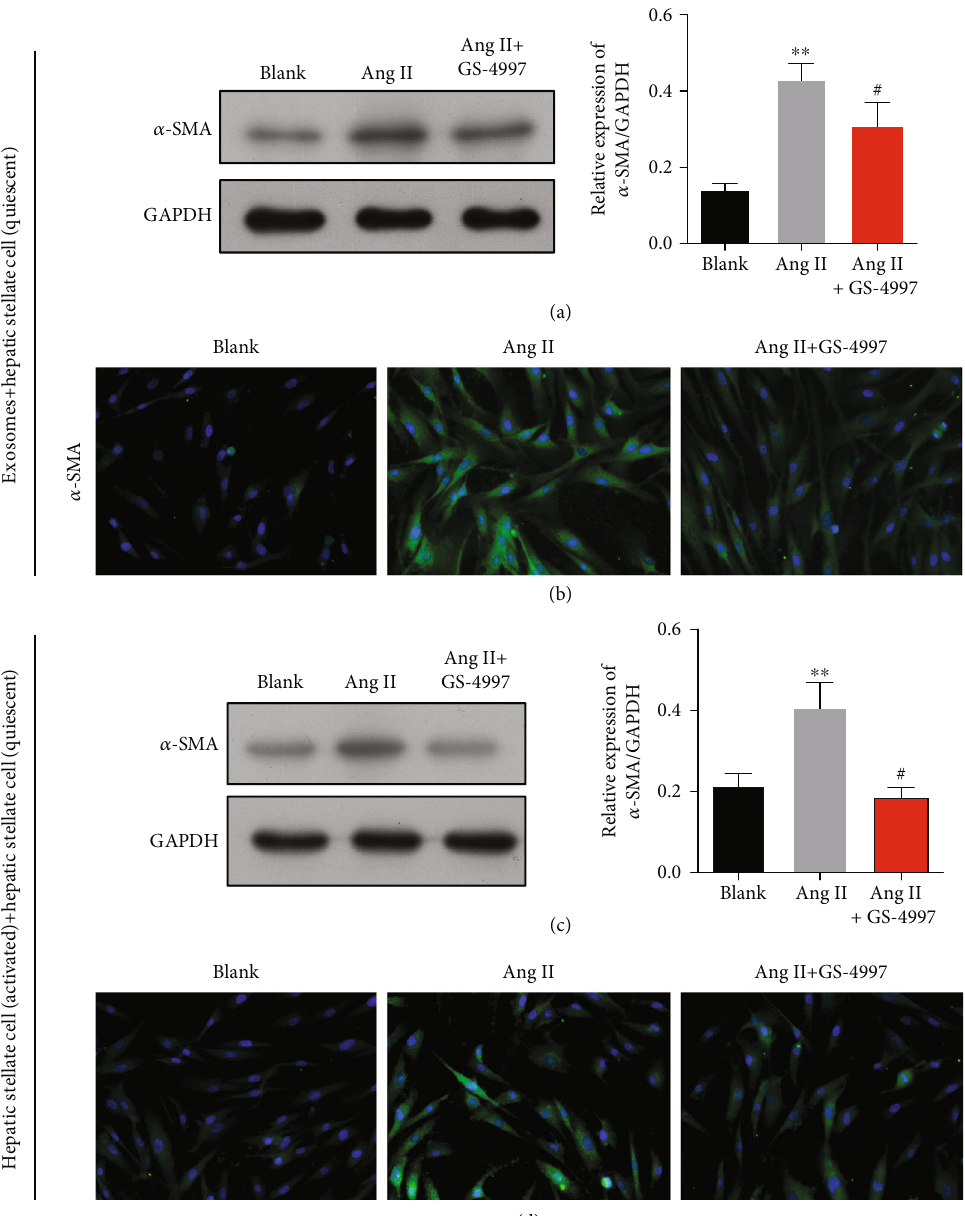
Figure 7: E ff ects of an ASK1 inhibitor on ERS-induced exosome release by activated HSC cells. LX-2 cells were treated with Ang II alone or cotreated with Ang II and an ASK1 inhibitor (GS-4997). Western blotting (a) and immuno fl uorescence staining (b) of α -SMA are shown in quiescent HSC cells incubated with activated HSCs. Western blotting (c) and immuno fl uorescence staining (d) of α -SMA are shown in quiescent HSCs cocultured with activated HSCs. Results are expressed as the meanvalue ± standard deviation (SD). ∗∗ p < 0 : 01 vs. blank. # p < 0 : 05 vs. Ang